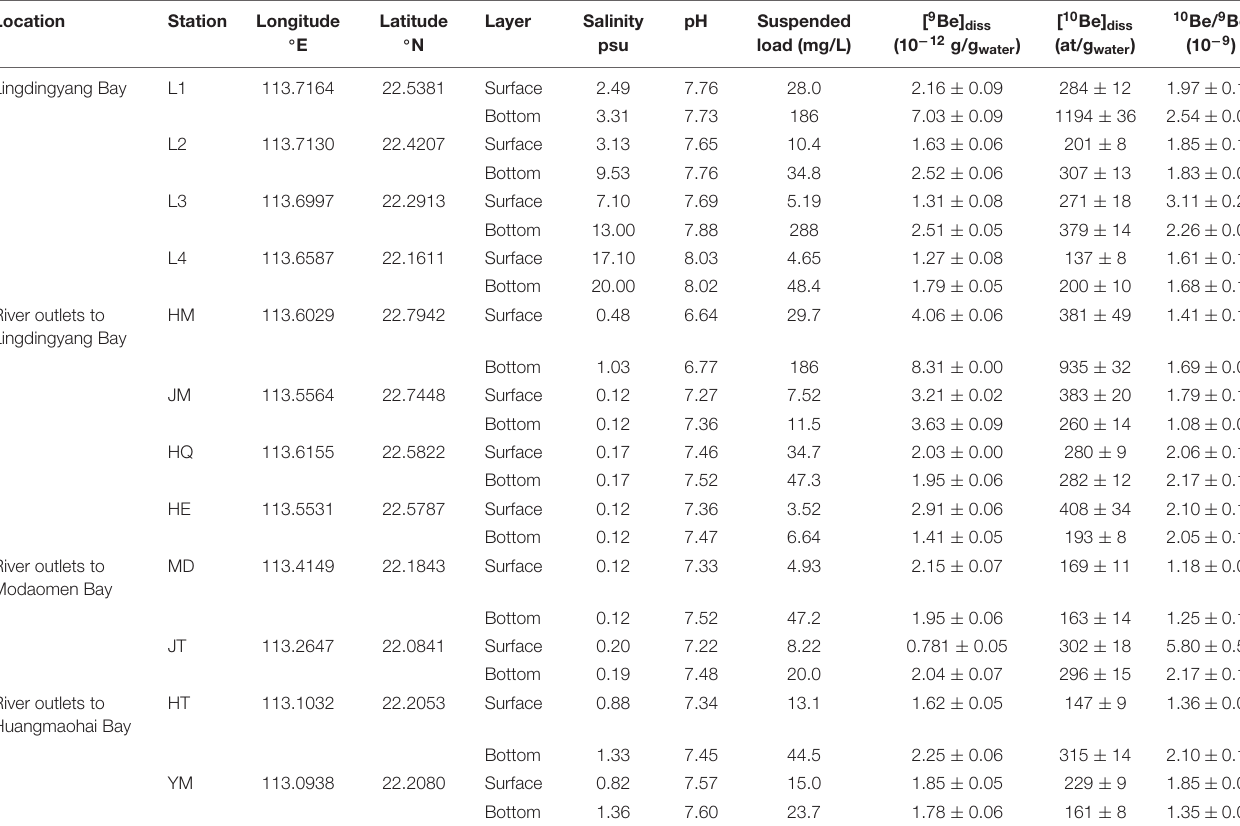
TABLE 1 | Dissolved beryllium isotope concentrations and 10 Be/ 9 Be ratios of all stations. Location